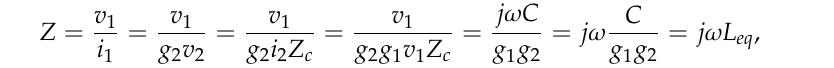
Figure 2a. To satisfy the real experimental condition, the high voltage FET-input op-amps (OPA445)